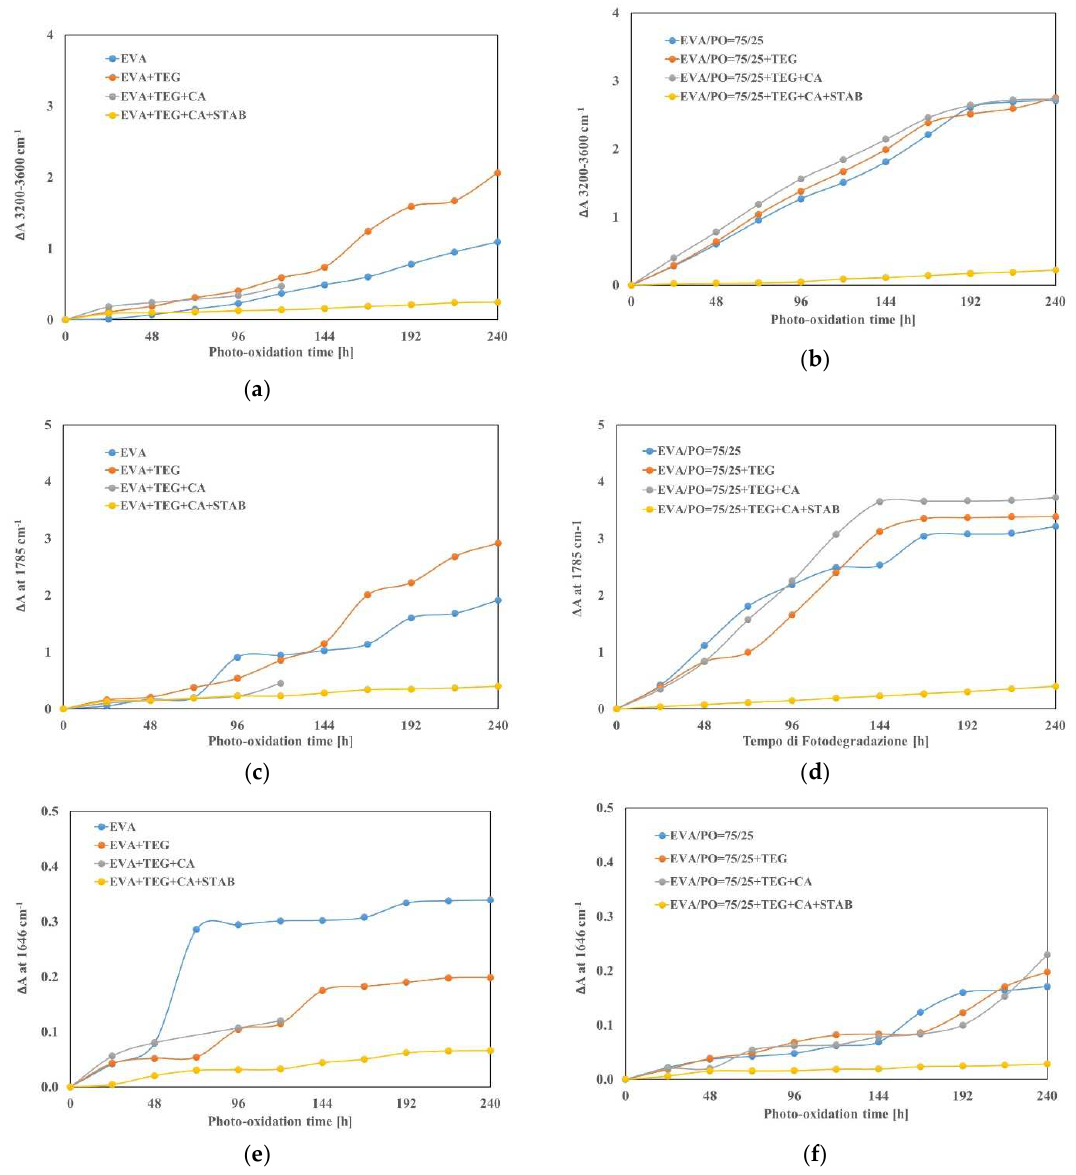
Figure 5. Variation of the peak areas at ( a , b ) 3200–3600 cm −1 , ( c , d ) 1785 cm −1 ( e , f ) and 1646 cm −1 for the EVA and EVA/PO = 75/25 wt.% samples with and without an adhesion promoter (TEG), a crosslinking agent (CA) and stabilizers (STAB).